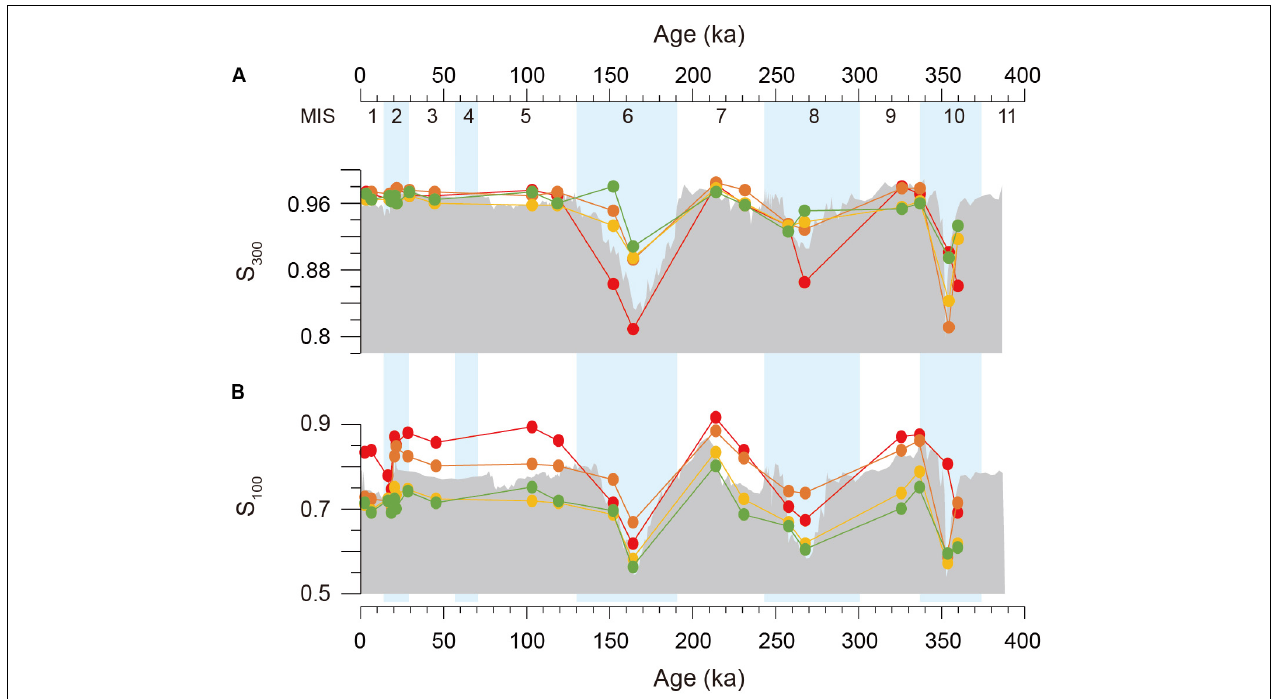
FIGURE 4 | (A) S 300 and (B) S 100 of bulk and size-fractionated samples. The lower S-ratios indicates greater contribution of high coercivity magnetic minerals. The color index is the same as in Figure 2